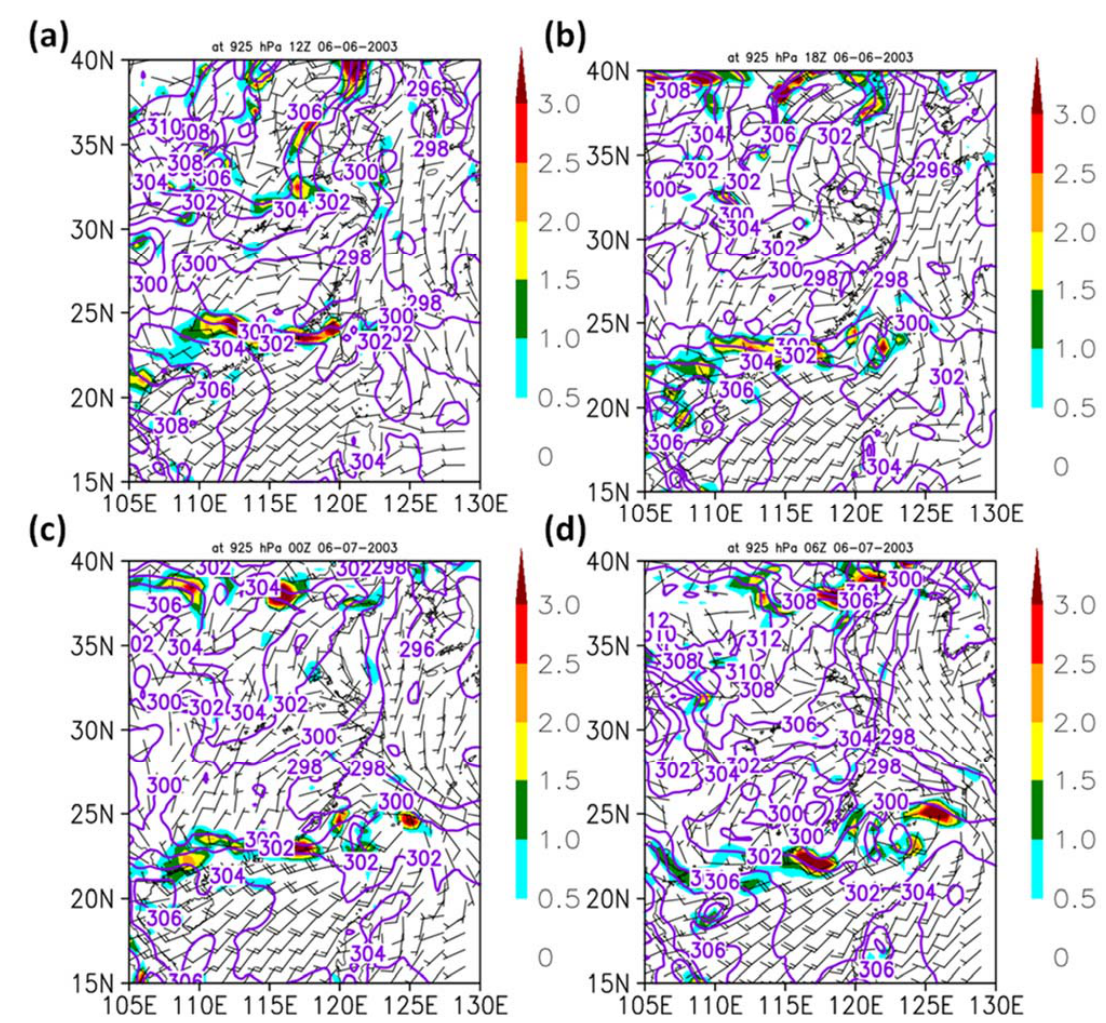
Figure 4. The CFSR frontogenesis at 925 hPa (10 − 9 K m − 1 s − 1 ), winds ( V ; m s − 1 , full barb and half barb represent 10 and 5 m s − 1 , respectively), and potential temperature (K, purple lines every 2 K) at ( a ) 1200 UTC (2000 LT) 6 June; ( b ) 1800 UTC 6 June (0200 LT 7 June); ( c ) 0000 UTC (0800 LT) 7 June; and ( d ) 0600 UTC (1400 LT) 7 June 2003.